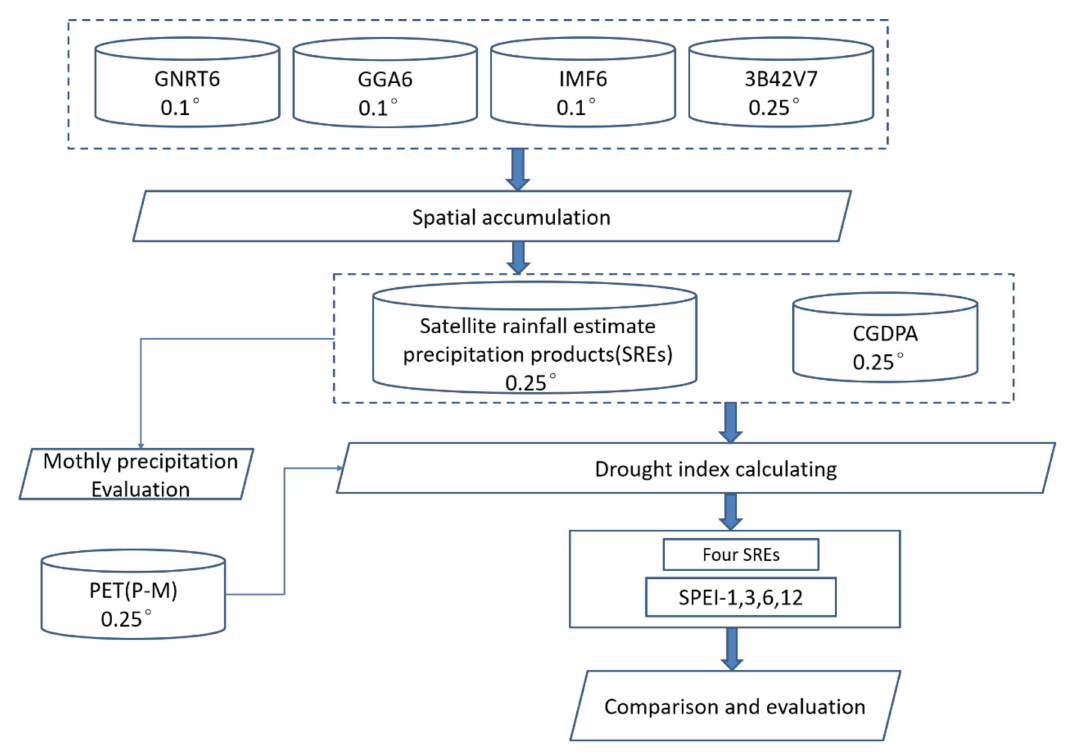
Figure 1. Flowchart of the